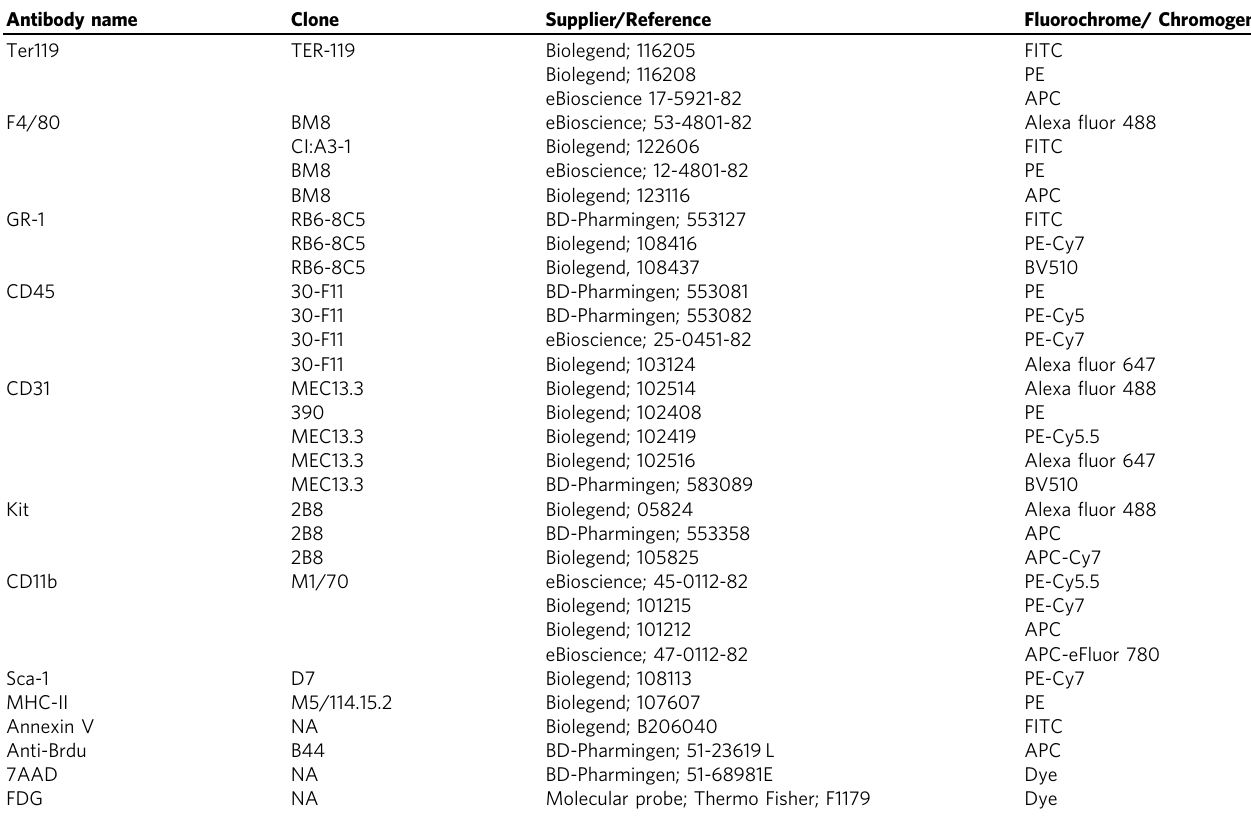
Table 3 Antibodies and fl uorescent stains used throughout this